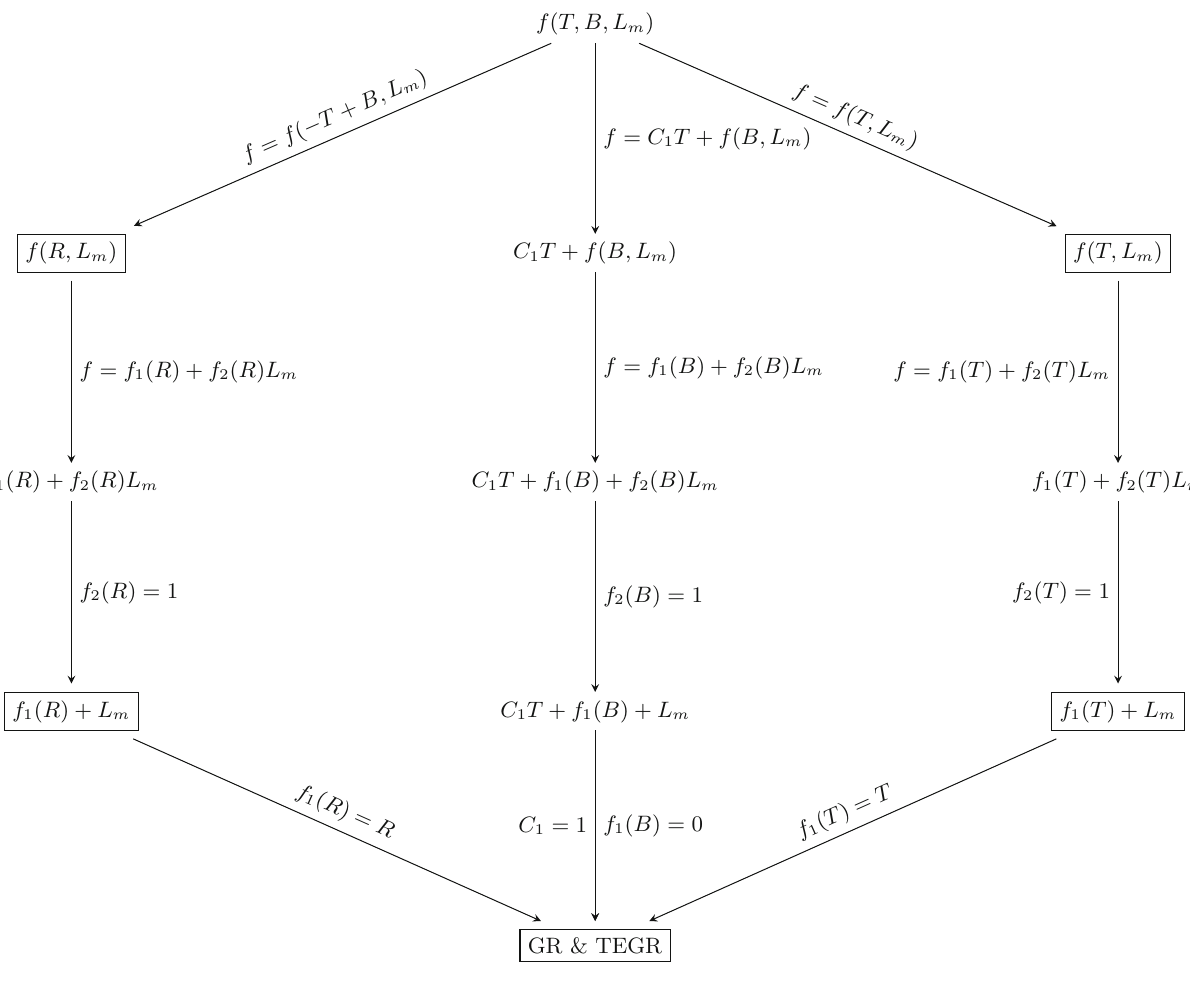
Fig. 3 Relationship between different modified gravity models and general relativity